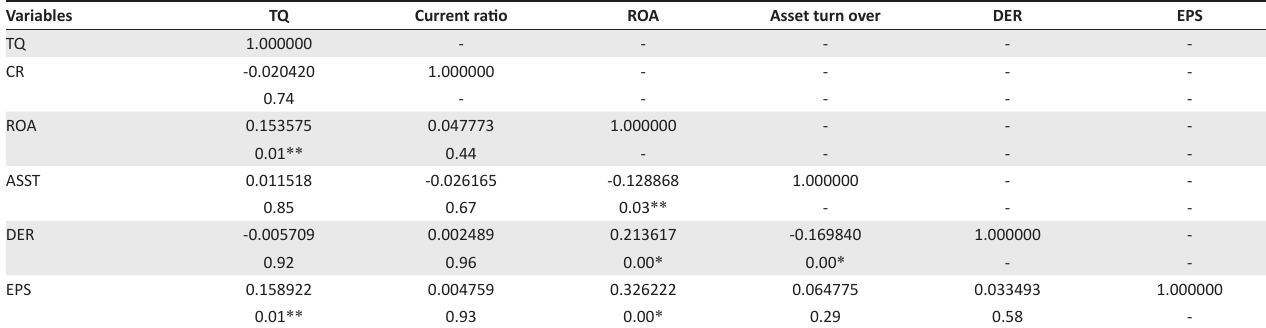
TABLE 2: Correlation matrix. Variables